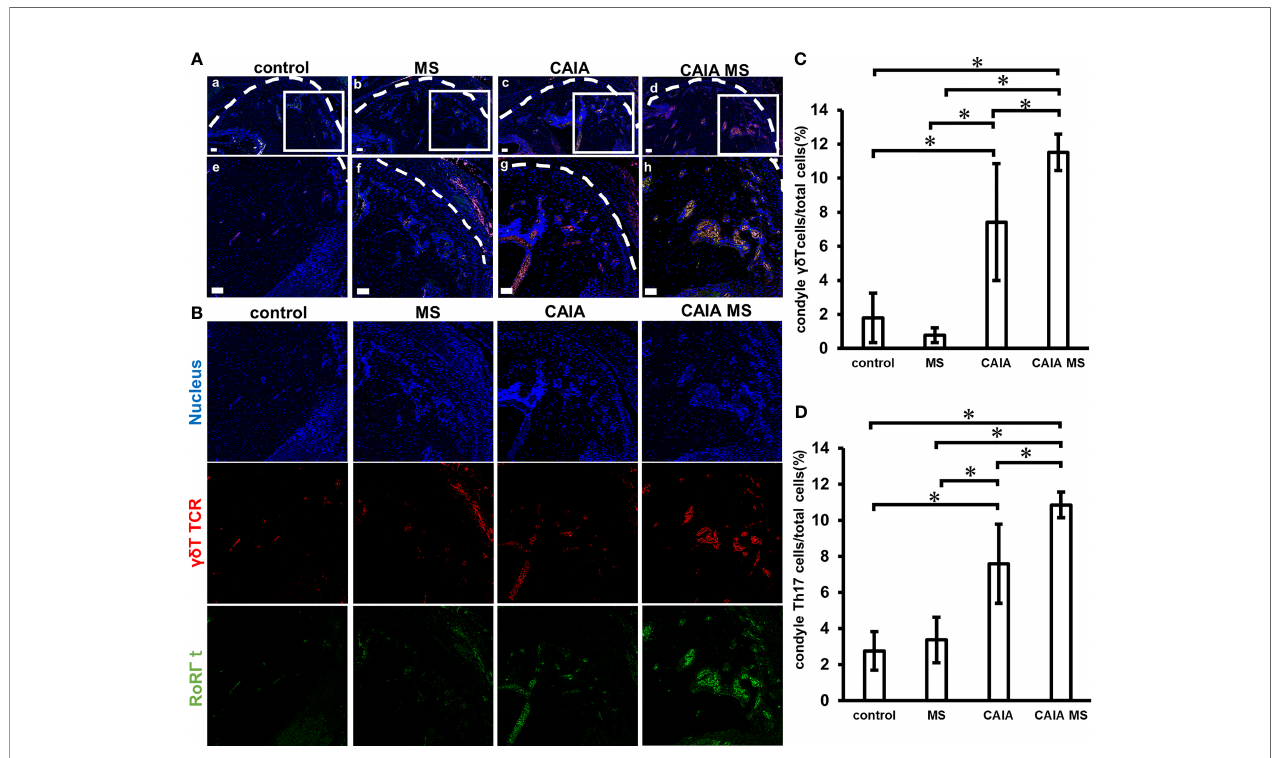
FIGURE 6 | Expression of gd T and Th17 cells in mandibular condyle by immuno fl uorescence staining. (A) Expression of mandibular condyle g d T and Th17 cells (a – d) Low magni fi cation, and (e – h) high magni fi cation. (scale bar: 50 m m; red: g d T cells, green: Th17 cells blue: cell nuclei) gd T and Th17 cells are mostly expressed in the subchondral bone of the CAIA MS group. (B) Expression of Th17 cells and gd T cells in the mandibular condyle by immuno fl uorescence staining. Representative images of 20x are shown in blue for nucleus, red for gd TCR, and green for RoR g t for each group. (C) Number of g d T cells in the mandibular condyle vs. the total number of cells (percentage). *P < 0.05 (D) Number of Th17 cells in the mandibular condyle vs. the total number of cells (percentage). *P <